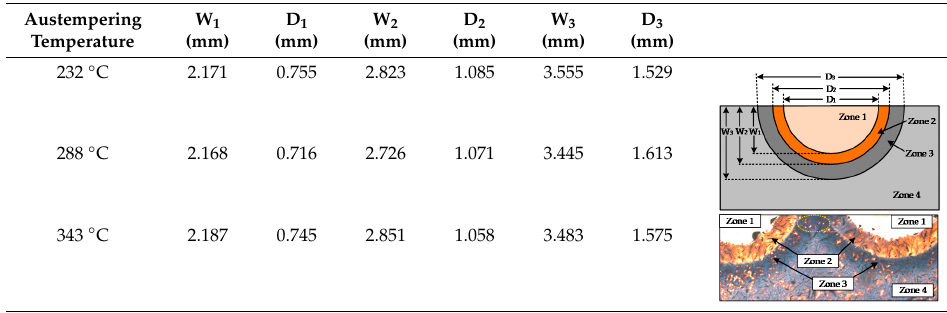
Table 4. Width and Depth of the Laser-Hardened, Upper Heat-Affected, and Lower Heat-Affected Zones for LHAGI Specimens with Various Austempering Temperatures.